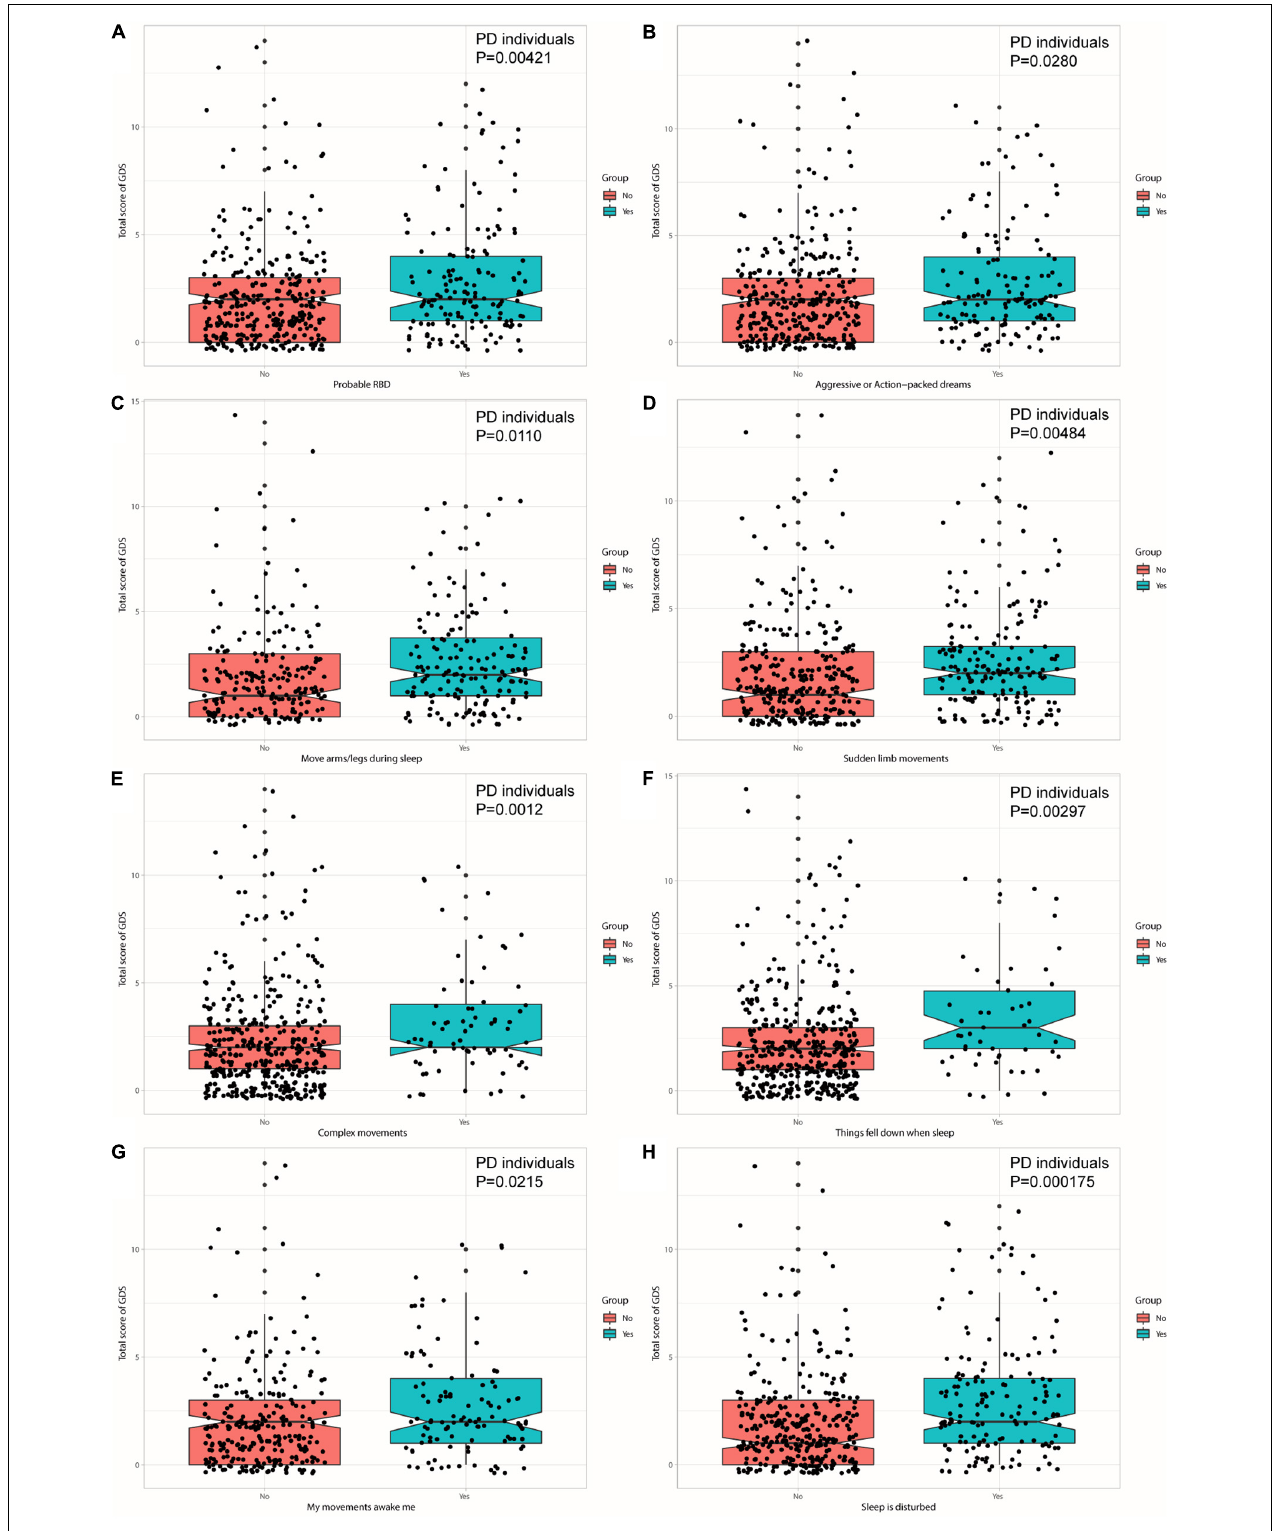
FIGURE 3 | Individuals with PD with pRBD (A) and specific behaviors—aggressive or action-packed dreams (B) , moving arms/legs during sleep (C) , sudden limb movements (D) , complex movements (E) , things falling down when sleep (F) , being awakened by one’s own movements (G) , and disturbance of sleep (H) contribute to a higher score of